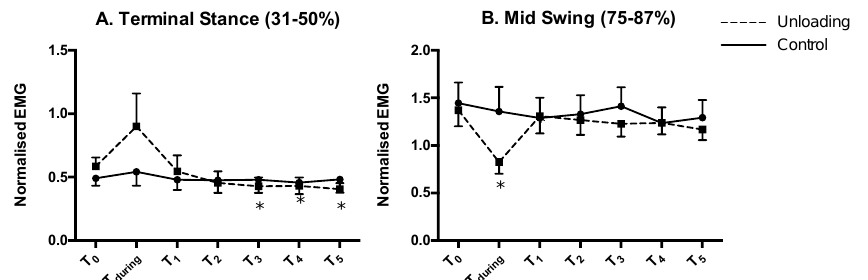
Figure 8. Group means ( ± SEM) of biceps femoris (BF) muscle activity during the ( A ) terminal stance and ( B ) mid-swing phases of the gait cycle during control and unloading conditions across different epochs. * Significant difference ( p < 0.05) relative to T 0 of the corresponding condition.